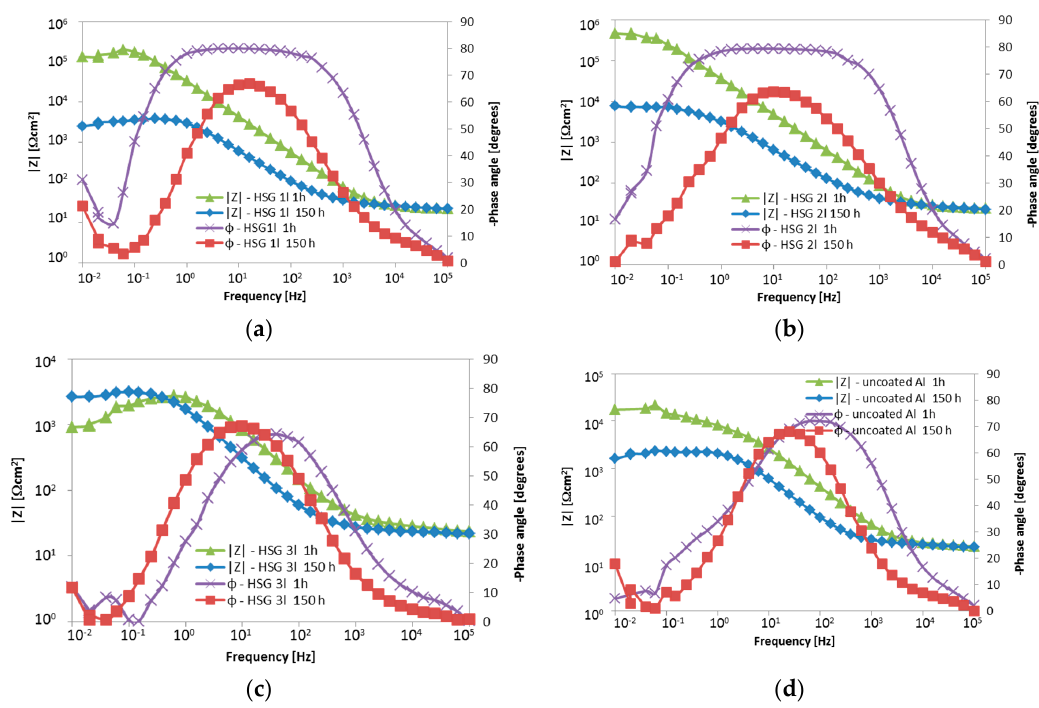
Figure 5. Bode plots of the hybrid organic–inorganic silane sol–gel coating (HSG) coated and uncoated aluminum alloy after 1 h and 150 h of soaking: ( a ) single-layer coating, ( b ) double-layer coating, ( c ) triple-layer coating and ( d ) uncoated AA2024; 0.5 M